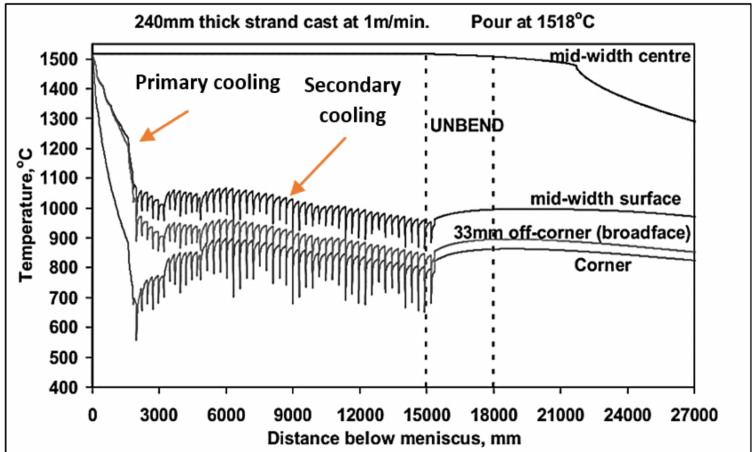
Figure 4. A 2-D computerised strand temperature model predicting the thermal history during continuous casting of a 240 mm thick strand cast at 1 m/min [20].